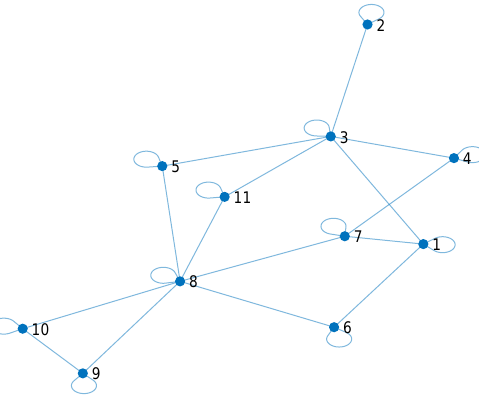
Figure 4. An overview of the adjacent matrix.